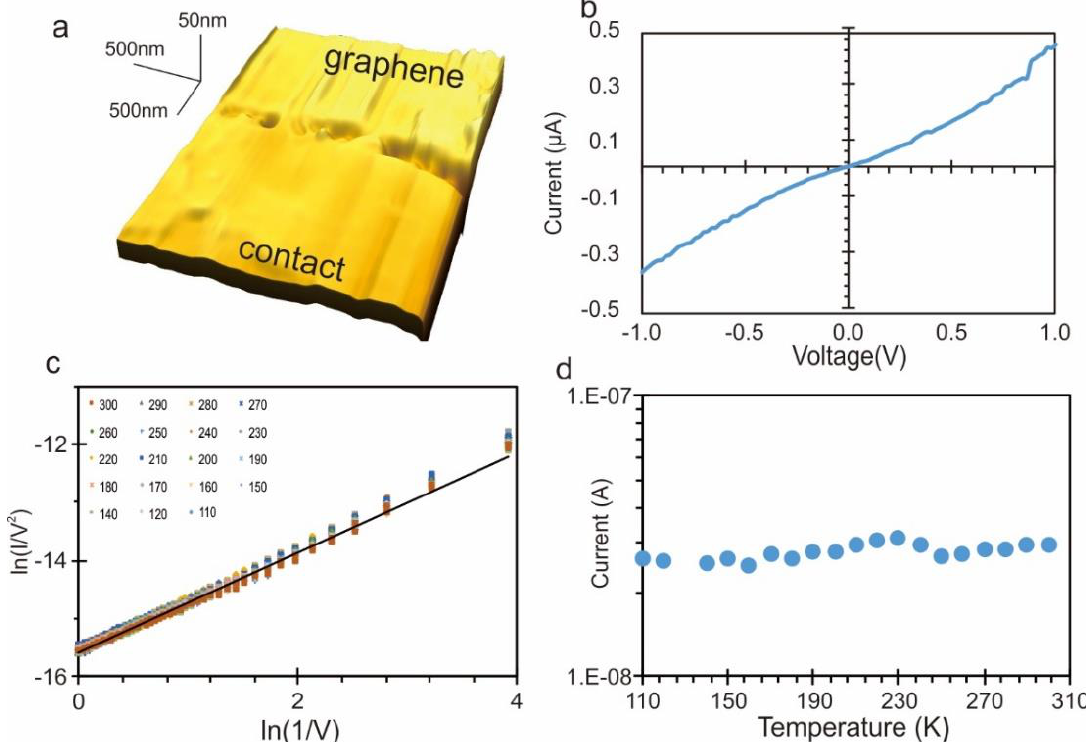
Figure 2. Carrier transport measurement of representative nanogap after 65s etching. ( a ) Atomic force micrograph of graphene/contact interface; ( b ) representative IV at room temperature; ( c ) FN-plot of IV at different temperatures; ( d ) current at a fixed voltage (0.2 V) vs. temperature.